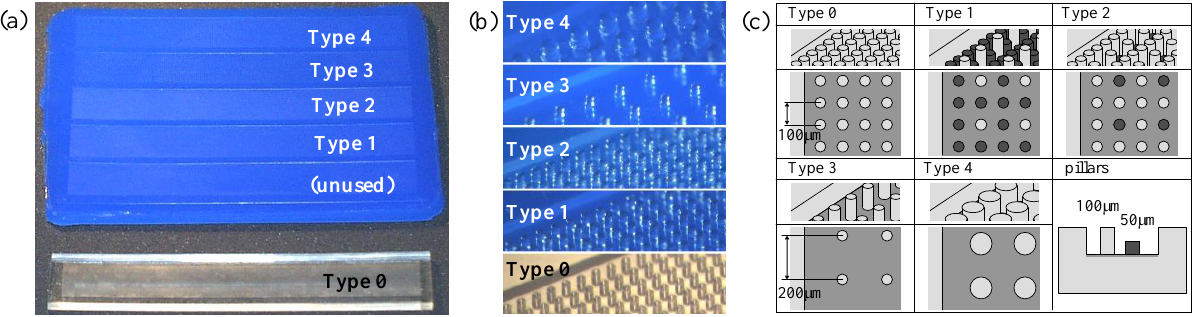
Fig. 2 Tested surface. (a) The PDMS chip surface is divided into regions with the different pillar patterns. (b) The pillars are regularly aligned on each region. (c) Long pillars (light gray) are 100  m in height, same as the depth of the grooved area (medium gray), while short pillars (dark gray) are 50  m in